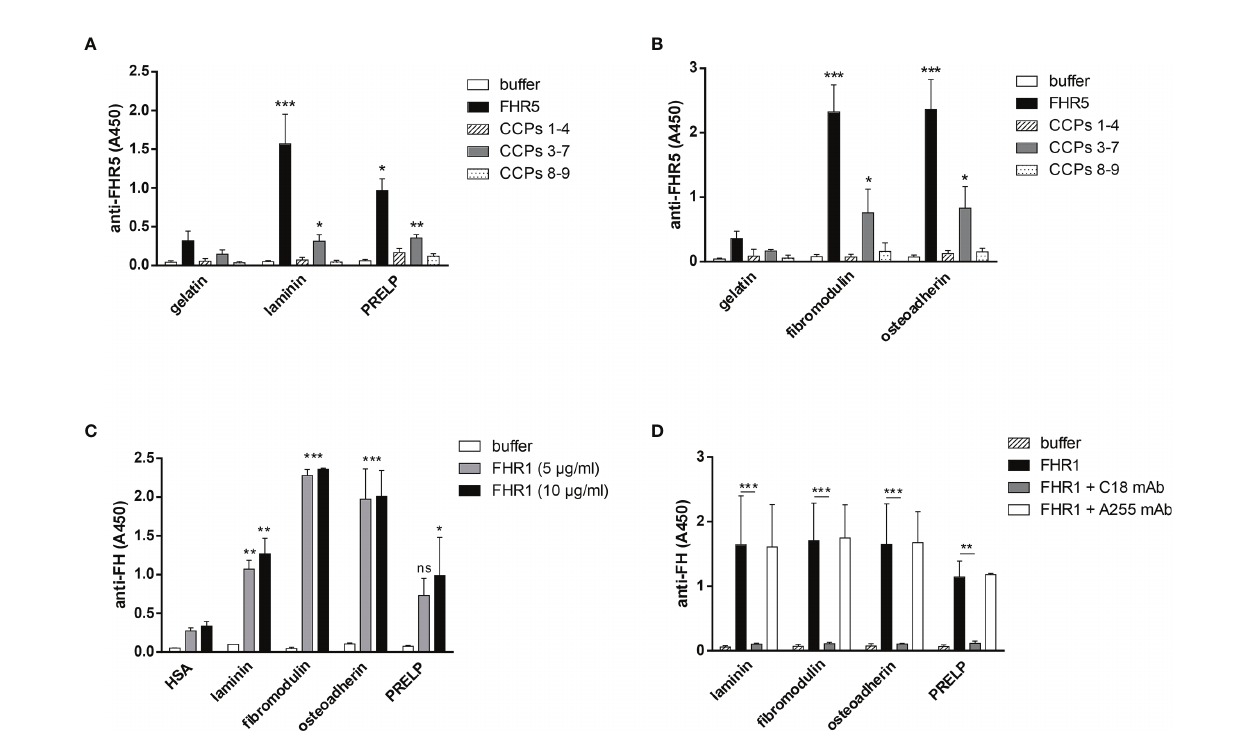
FIGURE 3 | FHR5 binds through its middle part, CCPs 3-7, and FHR1 binds via its C-terminal domain to ECM proteins. In ELISA 10 µg/ml of gelatin, laminin, PRELP (A) , osteoadherin and fi bromodulin (B) were immobilized in microplate wells and after blocking, incubated with 200 nM (A) or 100 nM (B) FHR5, CCPs 1-4, CCPs 3-7 and CCPs 8-9. Binding of FHR5 and its fragments was measured with goat anti-human FHR5 Ab. Data are means ± SD derived from three experiments. *p < 0.05, **p < 0.01, ***p < 0.001 one-way ANOVA, compared to the negative control, gelatin. (C) Laminin, fi bromodulin, osteoadherin and PRELP were immobilized (10 µg/ml) in microplate wells. After blocking, FHR1 was added in increasing concentrations. Binding of FHR1 was detected with polyclonal goat anti-human FH and the corresponding secondary antibody. Data are means ± SD derived from three independent experiments. *p <0.05, **p <0.01, ***p <0.001 two-way ANOVA, compared to the negative control, HSA; ns, not signi fi cant. (D) Immobilized ECM proteins were incubated with FHR1 (5 µg/ml) in the presence or absence of the monoclonal Ab C18, which recognizes the CCP 5 domain of FHR1. We used monoclonal Ab A255 as a negative control. Bound FHR1 was detected as described earlier. Data are means ± SD derived from three independent experiments. *p < 0.05, **p < 0.01, ***p < 0.001 two-way